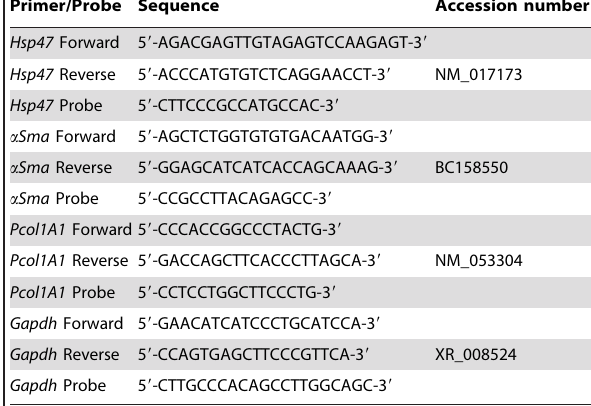
Table 1. Primers and